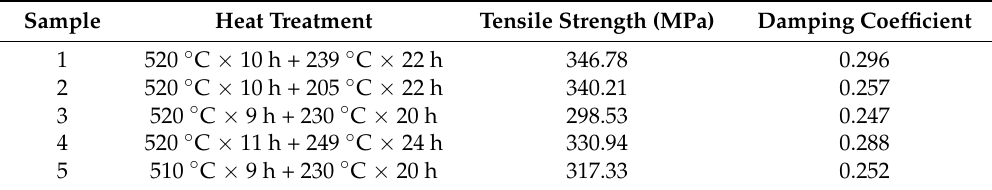
Table 8. Experimental parameters and results.